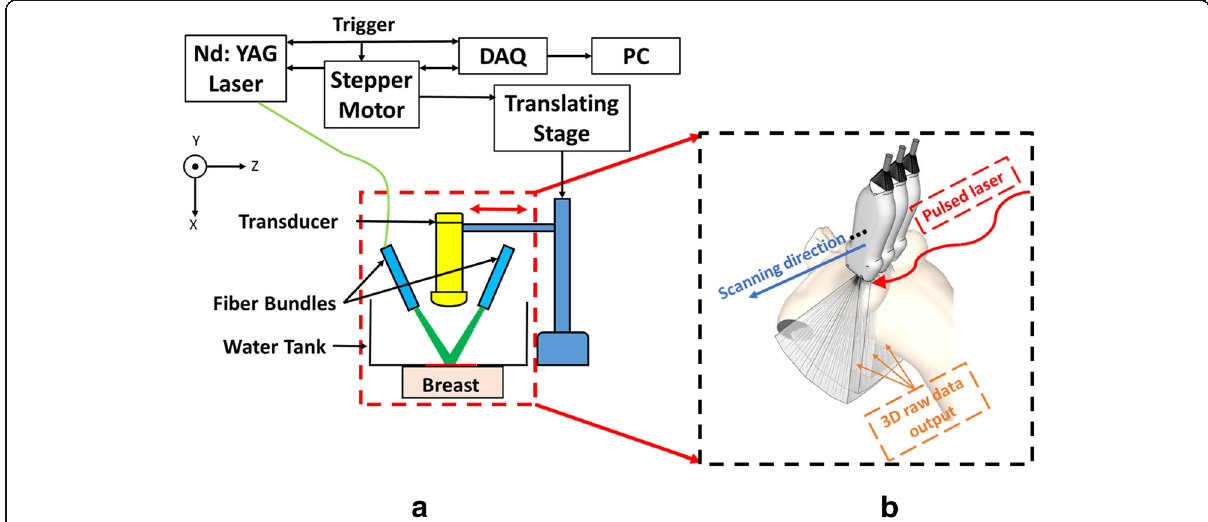
Fig. 3 Schematic drawing of PACT setup. a A 2D schematic showing all major components. b A 3D illustration of the scanning process. The laser beam causes the tissue to expand and release acoustic waves which are captured by the transducer. This process happens continuously along the moving (scanning)